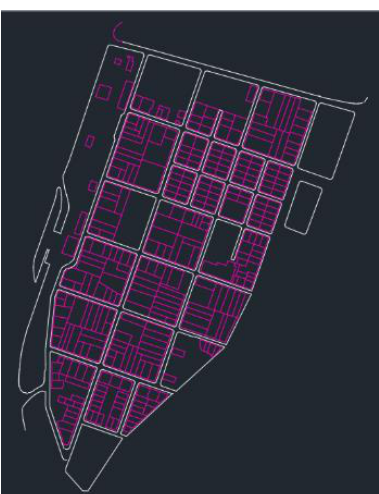
Figure 5. Cadastral Map